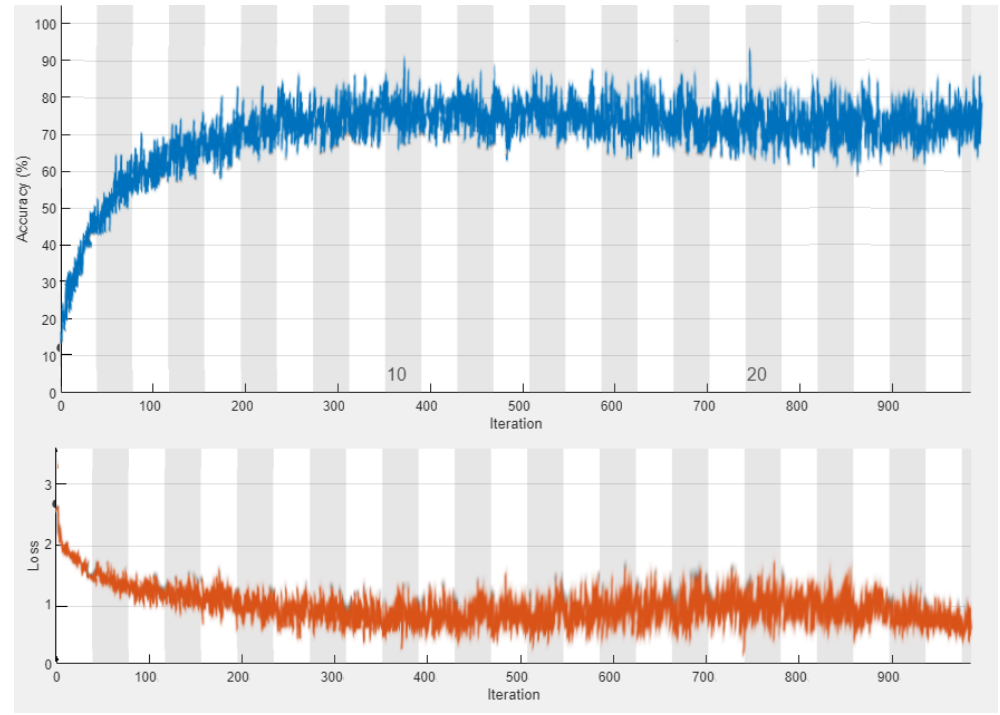
Figure 4. The learning curve with validation training accuracy and validation